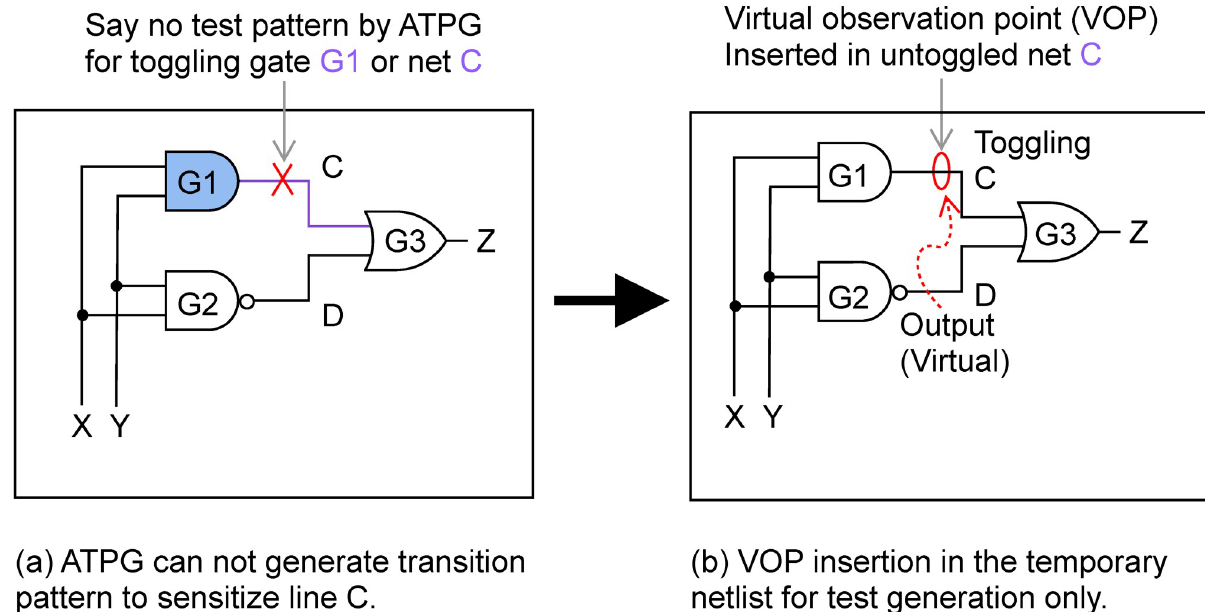
Fig 5. VOPs insertion in untoggled cells or nets: (a) ATPG patterns can not sensitize net C, (b) VOP insertion can ensure the untoggled net C toggling.